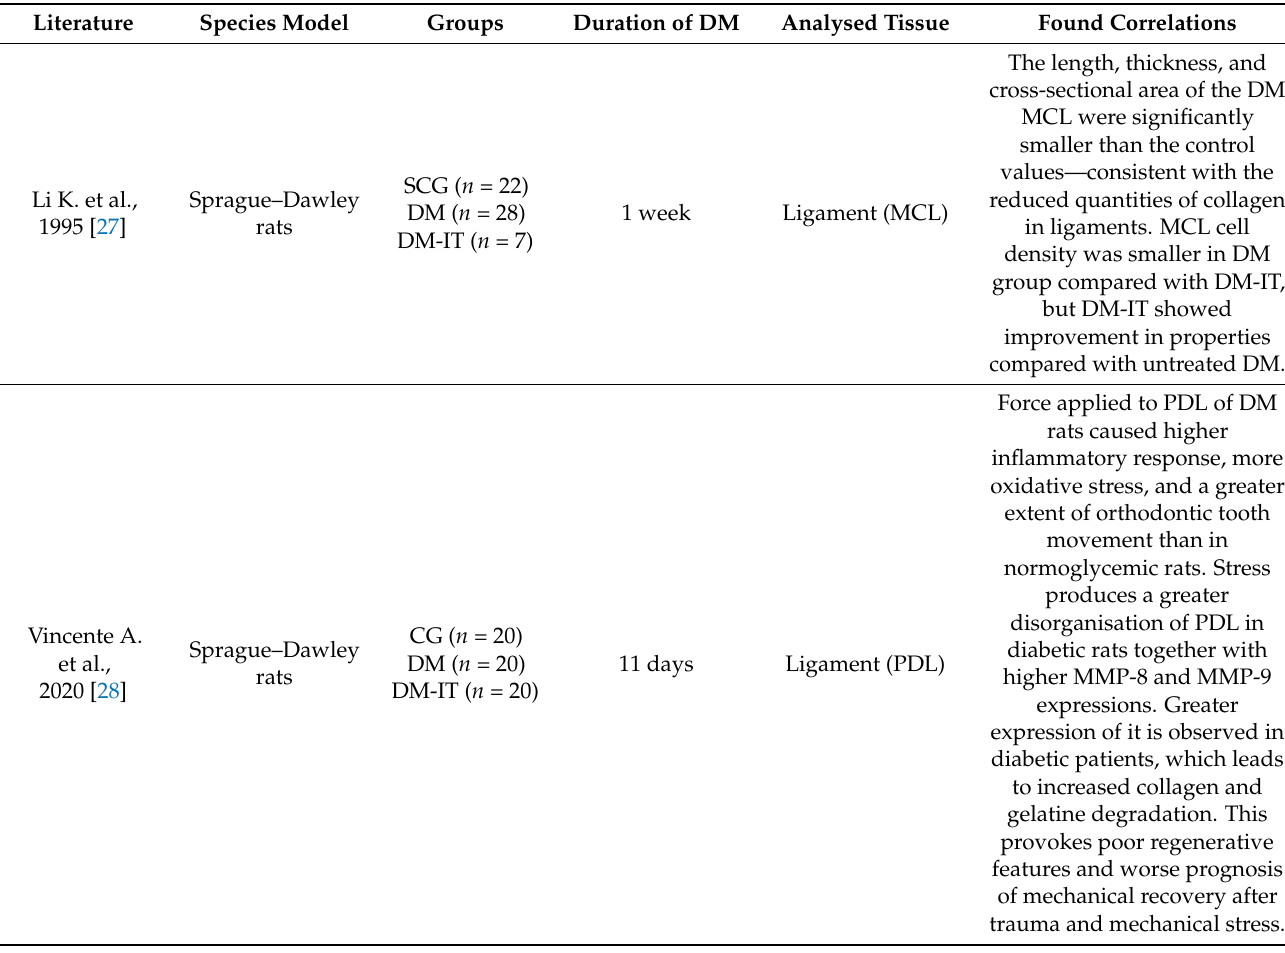
Table 1. Characteristics of studies on properties of ligament alterations among diabetic